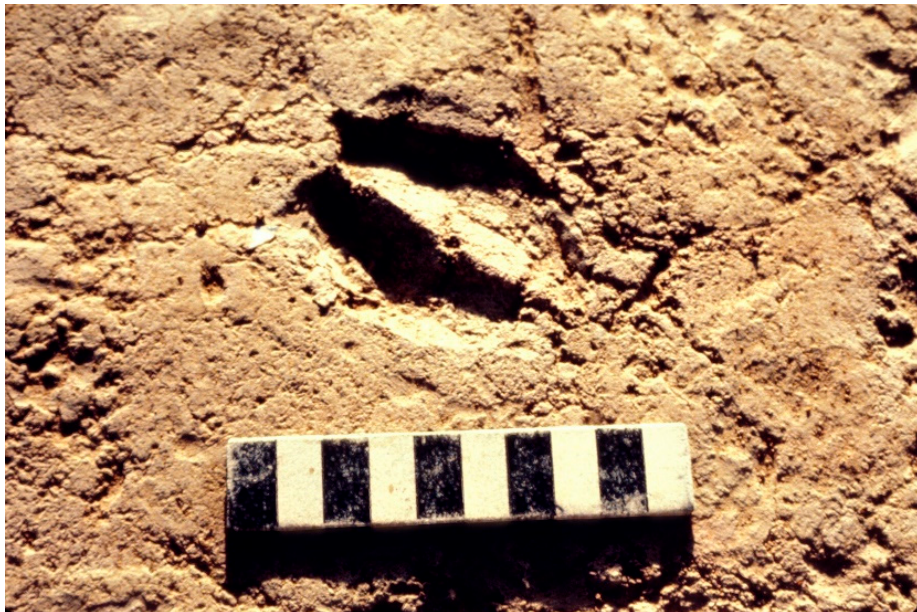
Figure A4. Prehistoric sambur deer tracks on the surface of a clay unit of the Baghor Formation Upper Member, Middle Son valley, north-central India, that was laid down 8000 years ago.